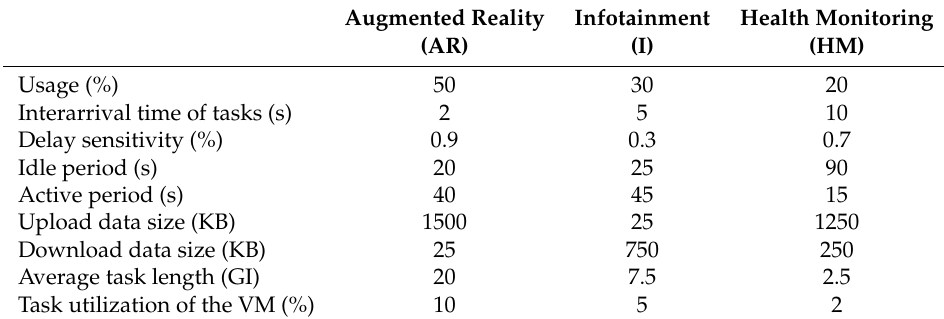
Table 5. Applications used in the simulations